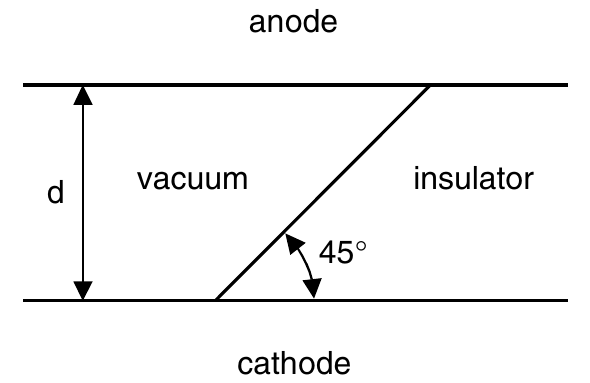
FIG. 1. Idealized 45 (cid:1) vacuum-insulator interface. (In a (cid:2) 45 (cid:1) configuration, the bottom electrode in the above configuration would be the